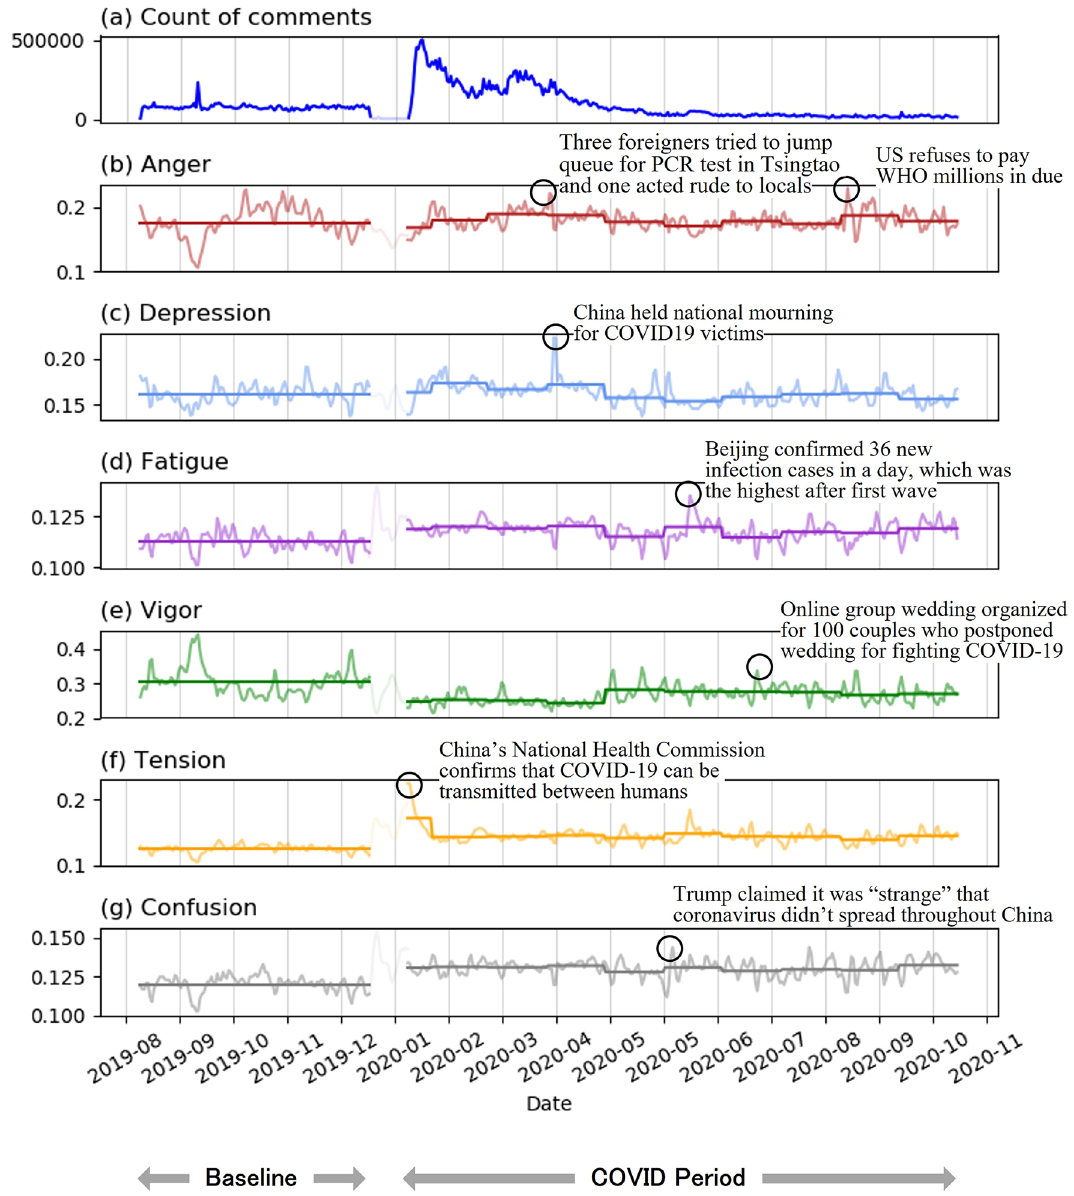
Figure 2. Normalized POMS emotion time series before and during the COVID-19 crisis in China. ( a ) The time series plot showing the daily number of comments related to COVID-19. ( b – g ) The time series plot showing the normalized daily number of comments under each emotion— Anger, Depression, Fatigue, Vigor, Tension and Confusion . The normalization is done by dividing the daily number of comments containing a specific emotion by the total daily number of comments. The key events that happened at the peak point of each time series plot are marked